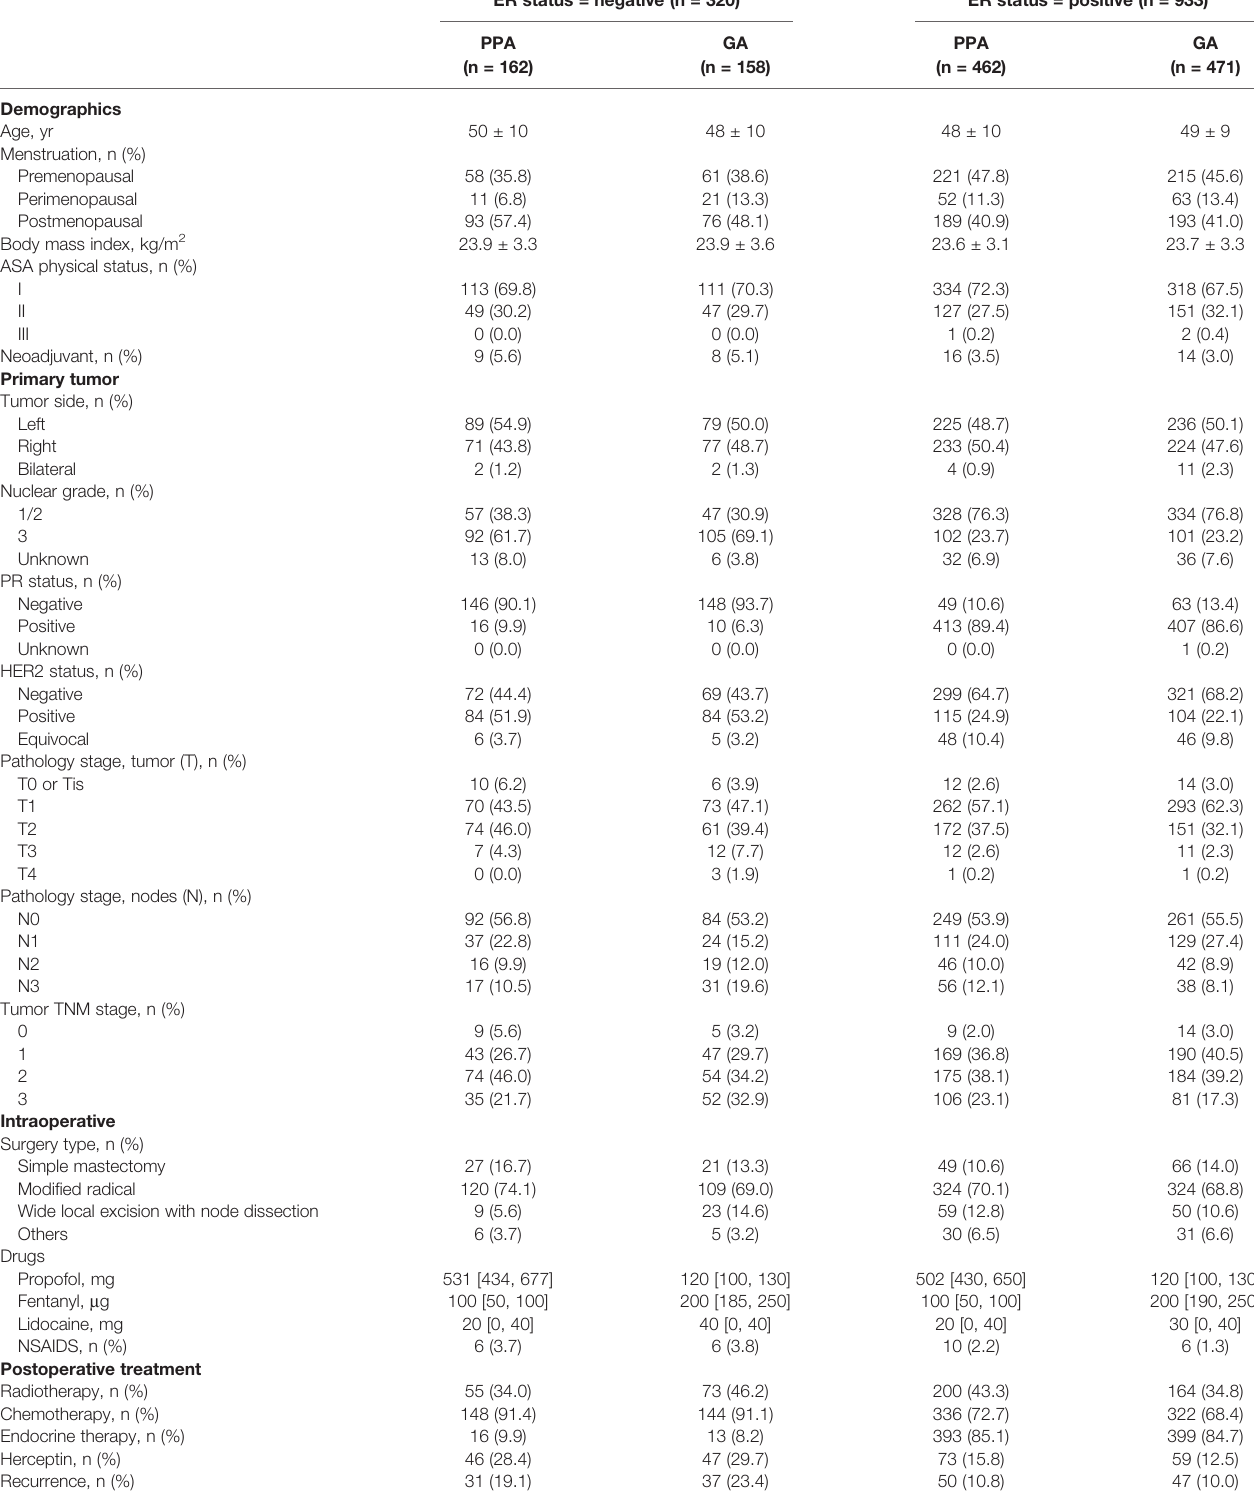
TABLE 1 | Demographic and clinical characteristics according to ER